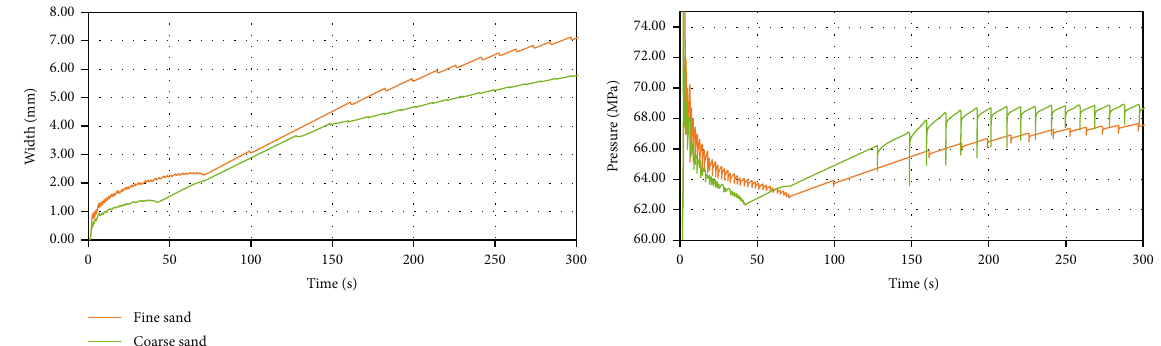
Figure 8: The in fl uence of the rock property on injection pressure and fracture width.